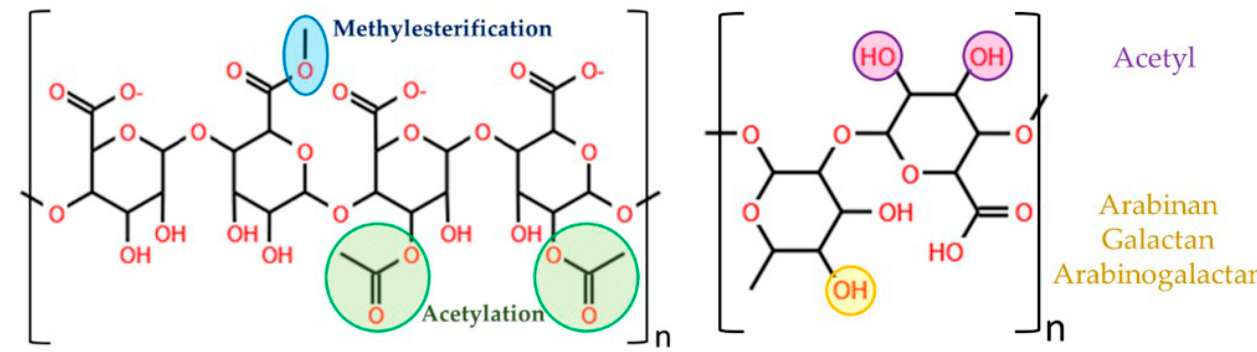
Figure 3. Basic structure of the homogalacturonan (left) and rhamnogalacturonan-I (right) backbones. In homogalacturonan, the carboxyl groups in C-6 are partially methylesterified (blue). The hydroxyl groups in C-2 and C-3 are partially acetylated (green). In rhamnogalacturonan-I, Rhap residues are substituted at C-4, indicated in yellow. The backbone residues of GalpA may be O-acetylated on C-2 and/or C-3, indicated in